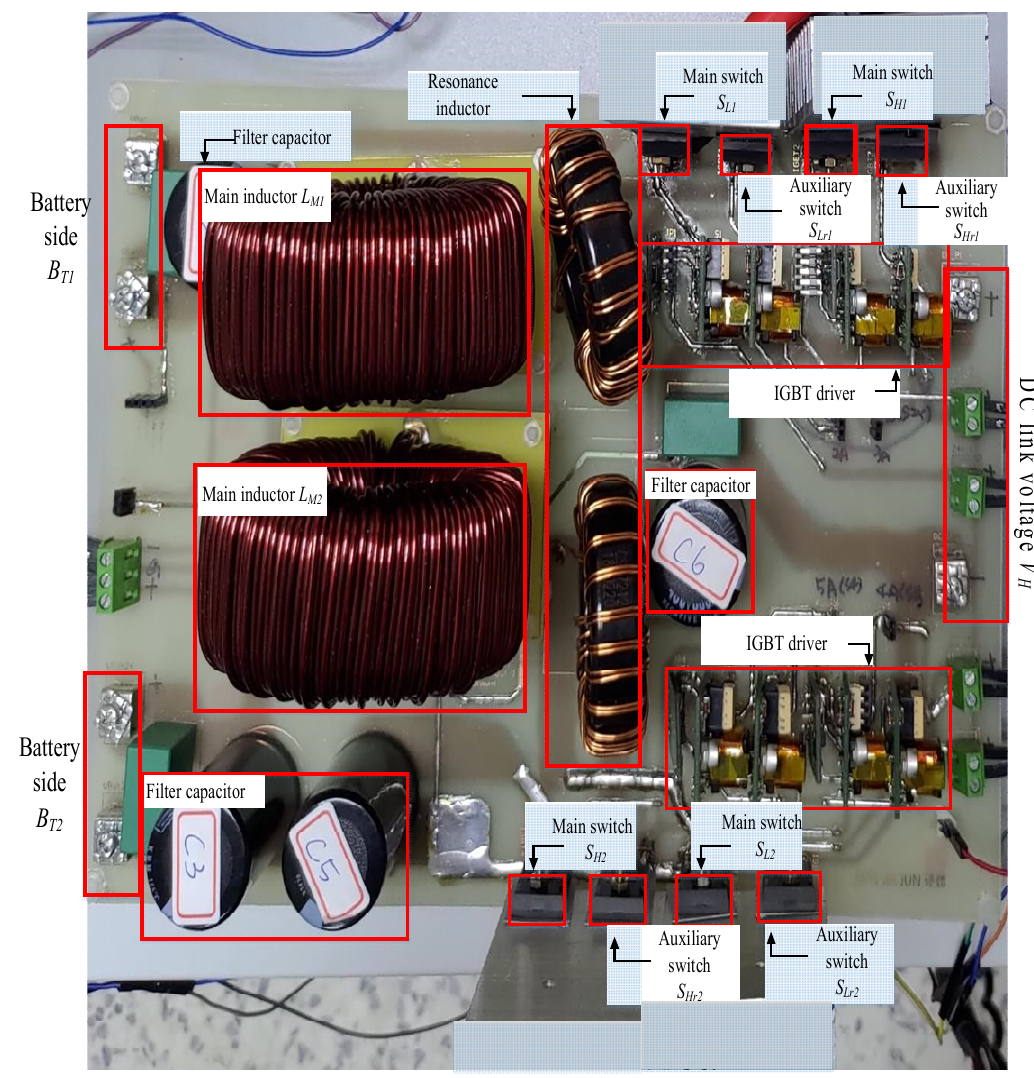
Figure 6. Dual sets serial connected bidirectional buck–boost soft-switching converter physical circuit diagram.